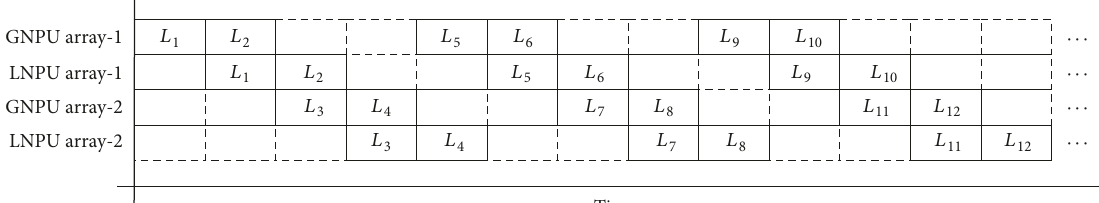
Figure 8: Layer-level view of the pipeline timing diagram for the GNPU and LNPU arrays when two NPU arrays are employed to process four layers. Due to the requirement of two NPU arrays, this method is inefficient compared to the two-layer pipelining method. Moreover, this method is not adopted for the implementation as the number of layers in a parallel run is limited by the number of ports in the shared memory.